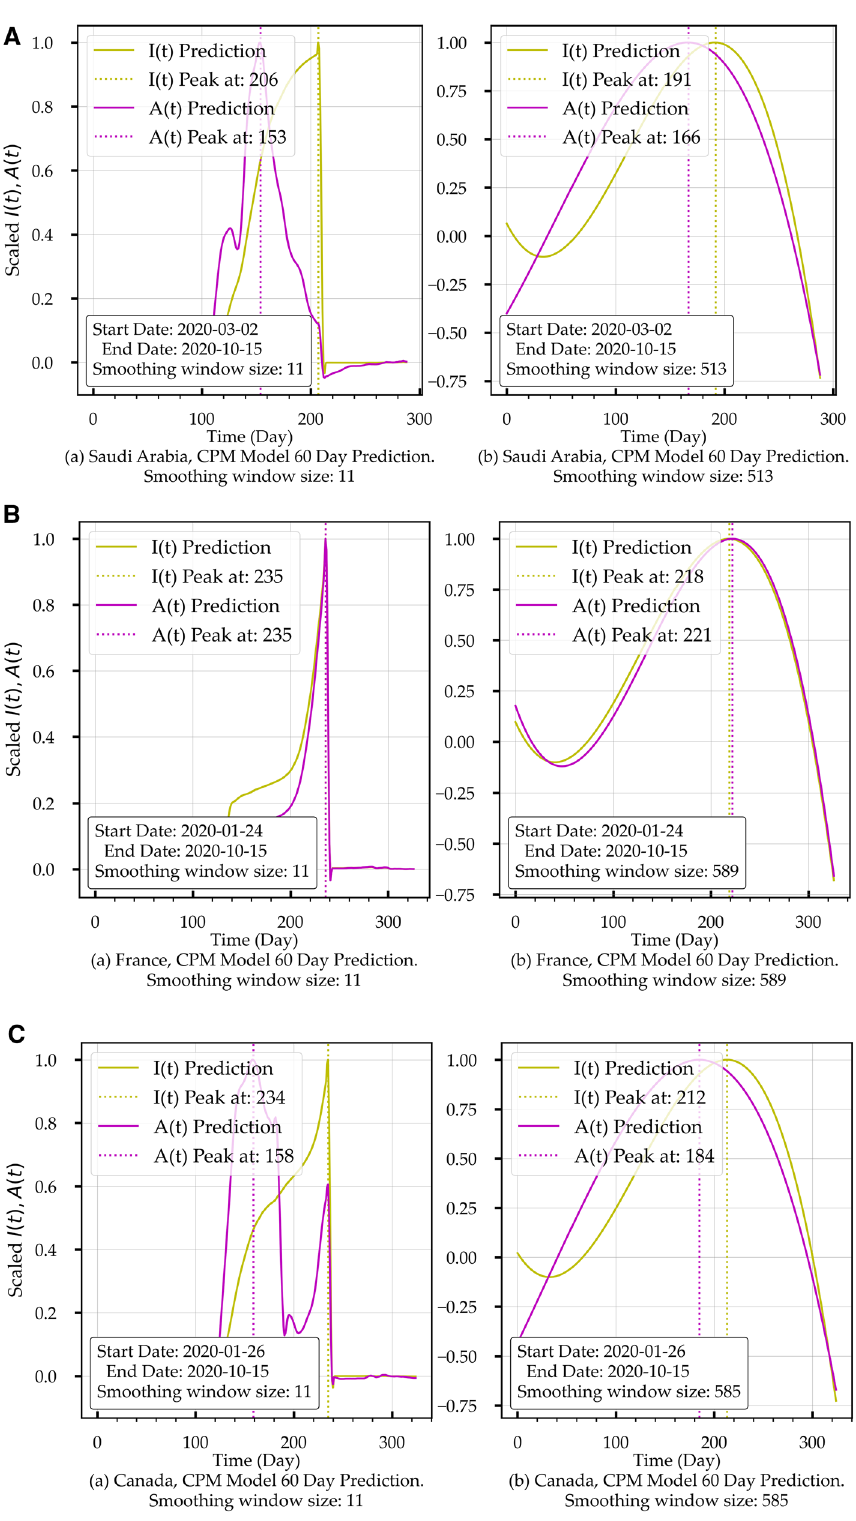
Figure 9. ( A ) Convolution Projection Model (CPM) Predictions for Saudi Arabia. (a) covers the period from 2020-03-02 to 2020-10-15. (b) covers the period from 2020-03-02 to 2020-12-02. ( B ) Convolution Projection Model (CPM) Predictions for France. (a) covers the period from 2020-03-02 to 2020-10-15. (b) covers the period from 2020-03-02 to 2020-12-02. ( C ) Convolution Projection Model (CPM) Predictions for Canada. (a) covers the period from 2020-03-02 to 2020-10-15. (b) covers the period from 2020-03-02 to